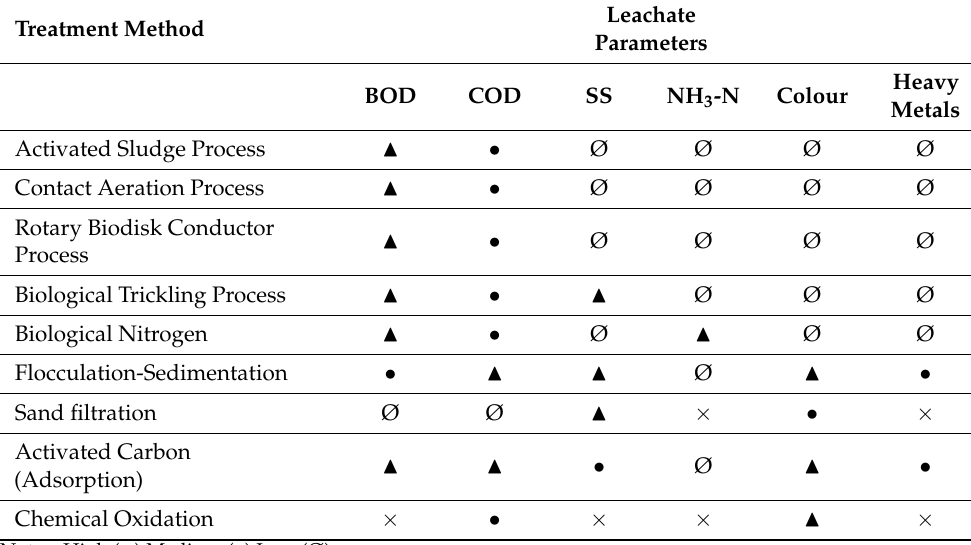
Table 4. Removal of leachate parameters by various applications performance [20].